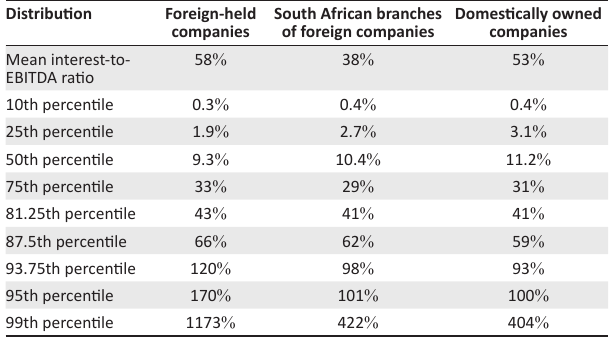
TABLE 3: Distribution of mean interest-to-EBITDA ratios.